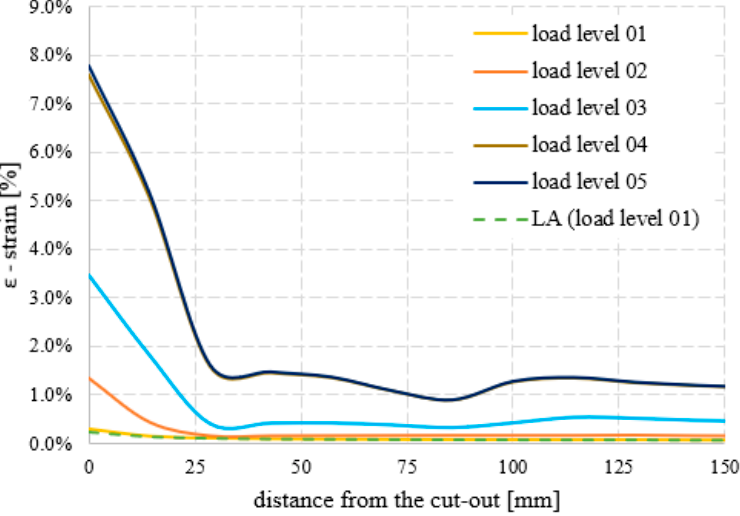
Figure 15. Strains obtained along the evaluation path for the four load levels tested.